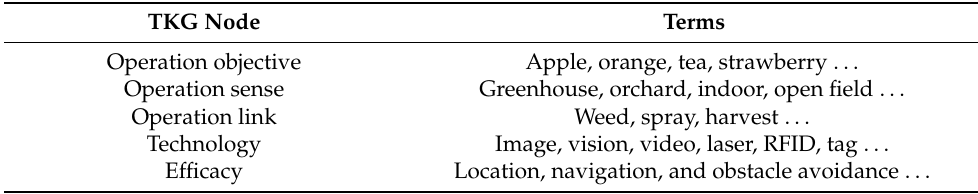
Table 3. Terms for the agricultural robot design TKG.